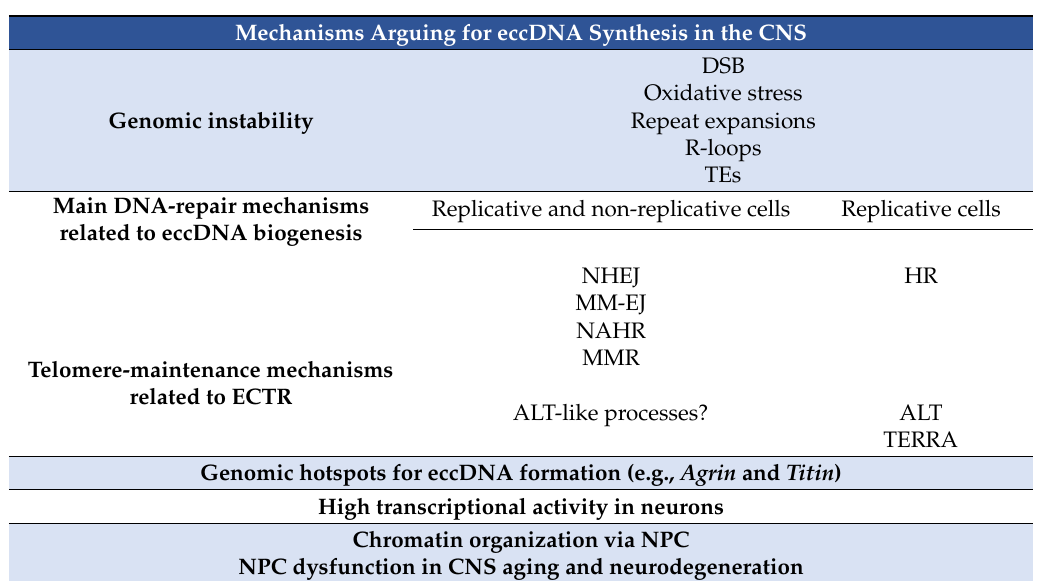
Table 1. Processes related to extrachromosomal circular DNA (ecc / ecDNA) biogenesis with putative operation in the central nervous system (CNS)